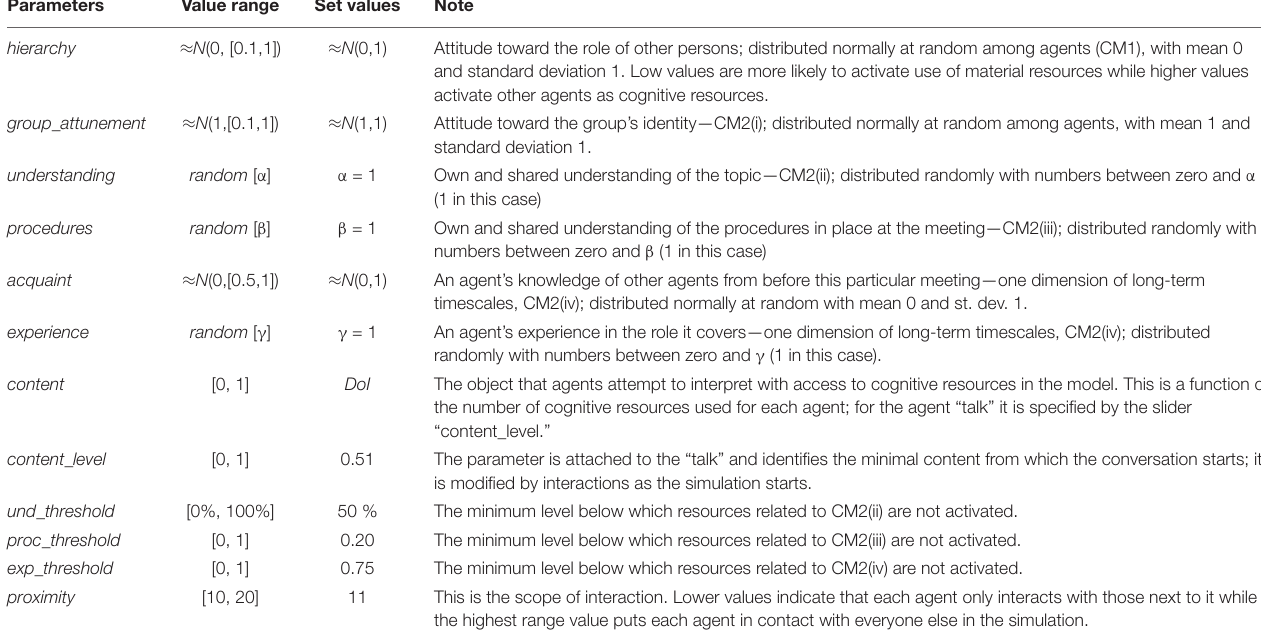
TABLE 2 | Parameters and